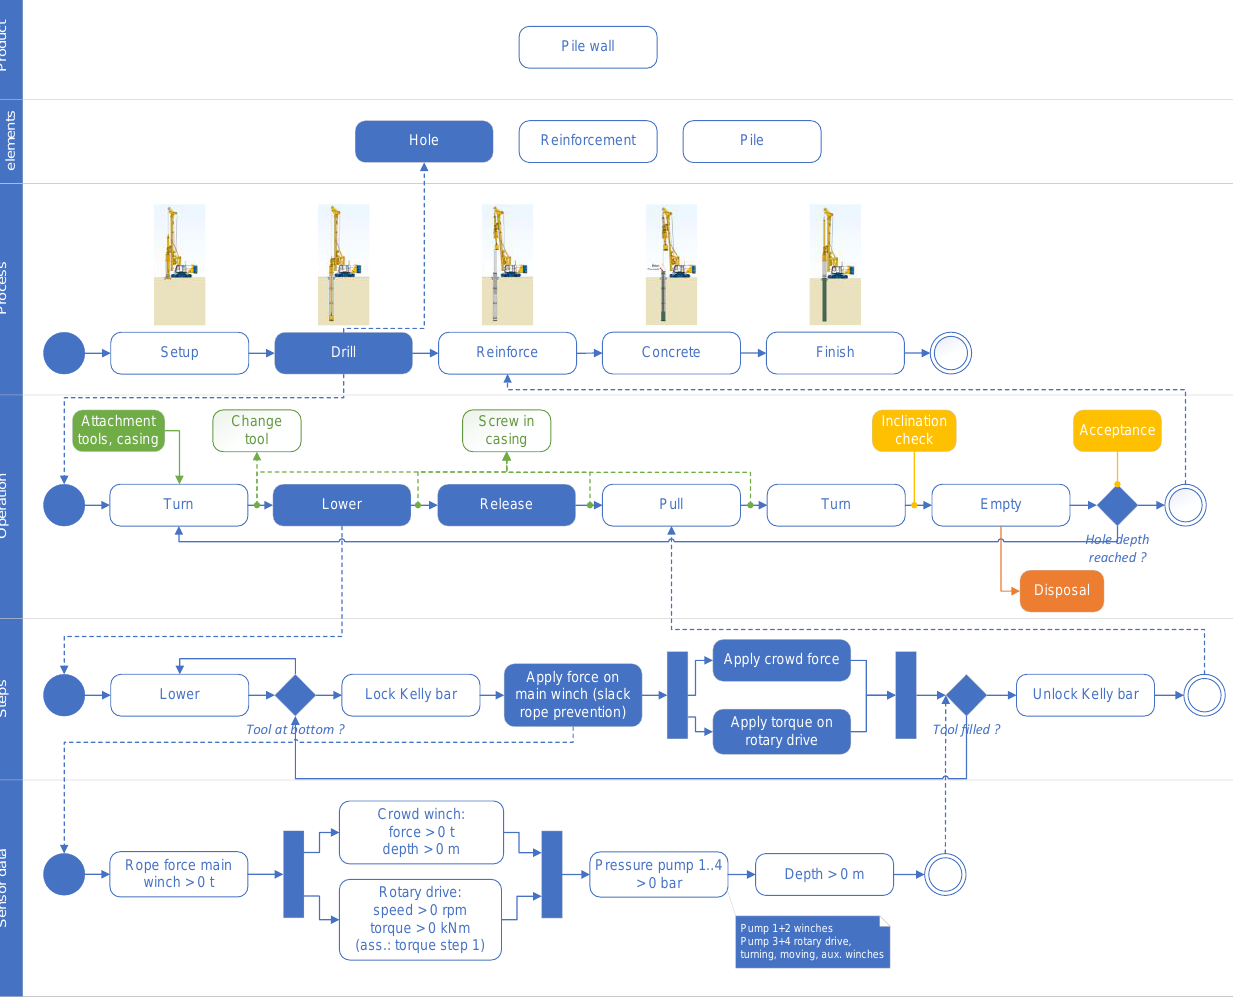
Figure 15. Activity diagram of the Kelly pile production system and its flows (material supply (green)/removal (orange), information (yellow)) focusing on the process step ‘Drill’ (blue).